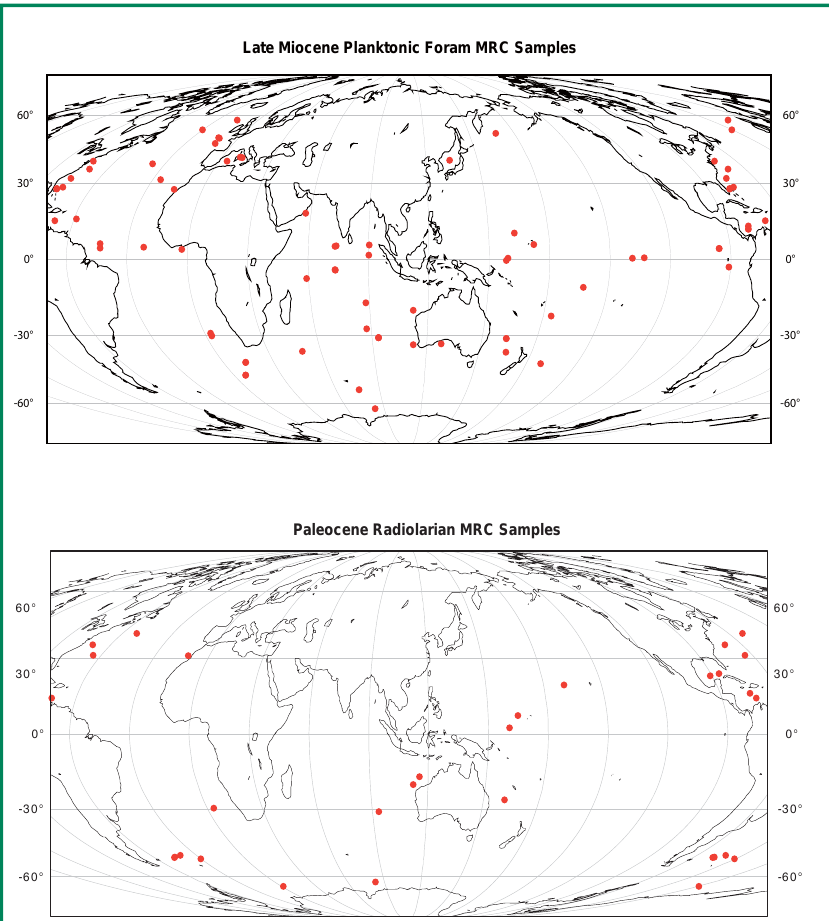
Figure 4. Location maps of MRC samples for selected time intervals. Late Miocene time in- terval is only half as long as Paleocene. Note: to show full Pacifi c basin, eastern Atlantic (and data plotted there) is duplicated on right edges of maps.